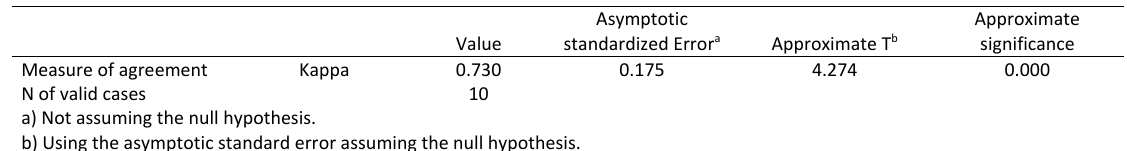
Table 3: Kappa coefficient estimation Symmetric measures